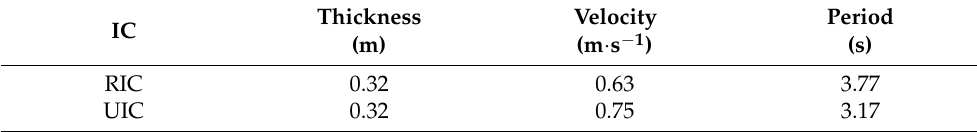
Table 6. The design ice load for the simulation.